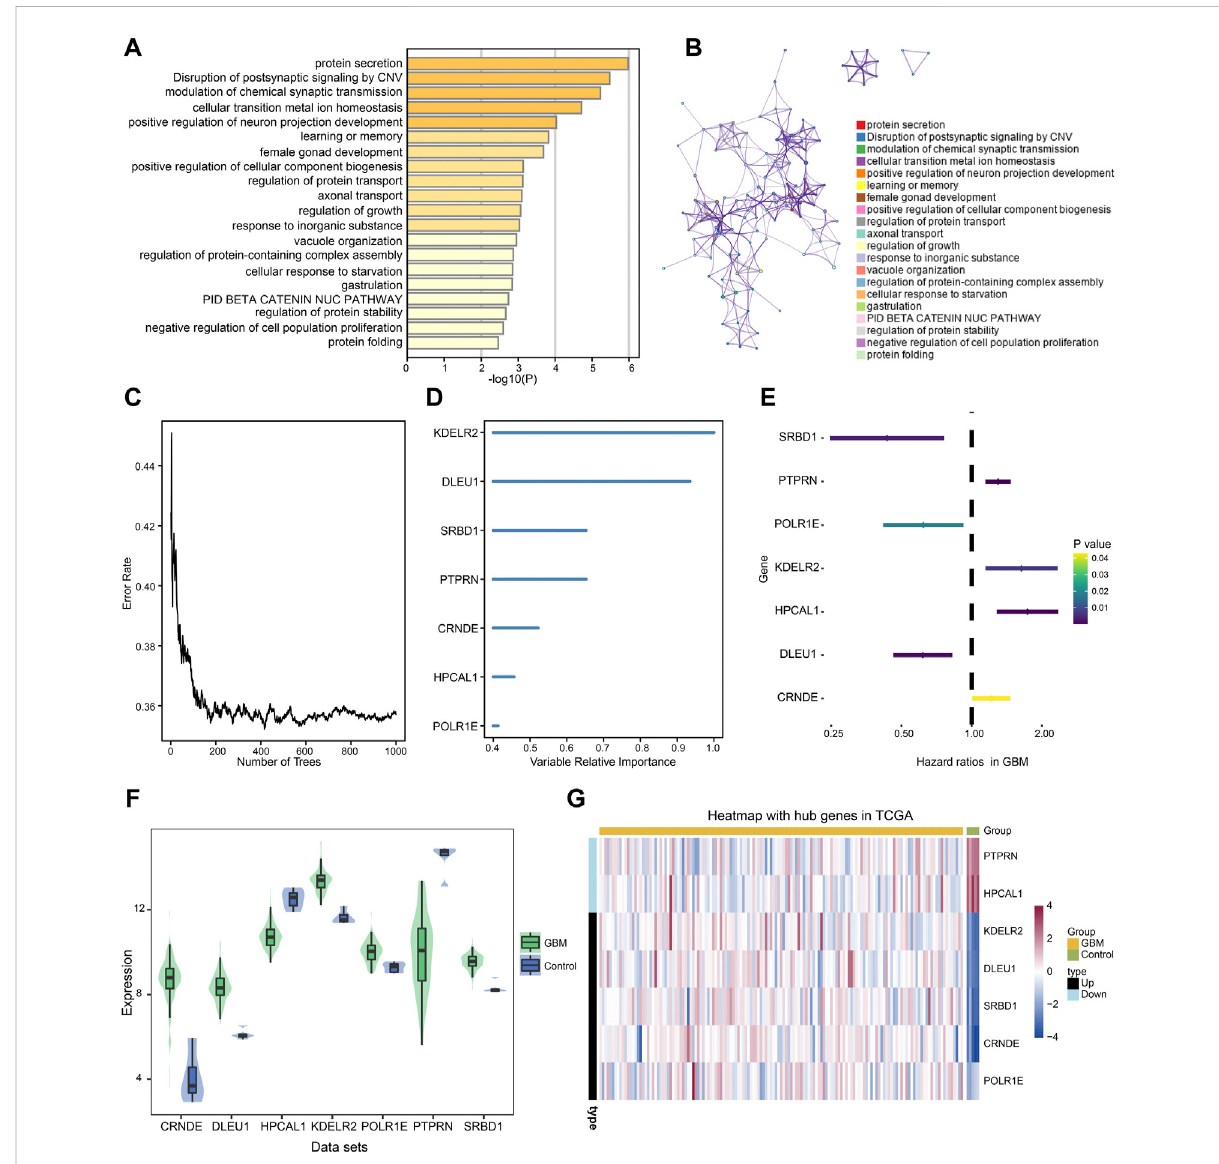
FIGURE 4 Metascape enrichment analysis of 91 prognosis-related genes and identi fi ed the hub genes in glioblastoma (GBM). (A) Gene Ontology (GO) terms and Kyoto Encyclopedia of Genes and Genomes (KEGG) pathways involved in 91 prognosis-related genes. (B) The interactions of these GO terms and KEGG pathways. (C) Relationship between error rate and number of trees. (D) Random forest model was performed to determine the importance of the seven genes. (E) Forest plot of the multivariate Cox regression analysis in prognosis-related genes. The genes with a hazard ratio (HR) > 1 were identi fi ed as associated with prognostic risk factors, an HR < 1 was considered a protective factor. (F) Violin plot showed the expression of seven hub genes in control and GBM samples. The thick black bar in the middle indicates the interquartile range, and the black line extending from it represents the 95% con fi dence interval. (G) Heat map showed the expression of seven hub genes in GBM and control samples in TCGA dataset. GBM, glioblastoma; TCGA, The Cancer Genome